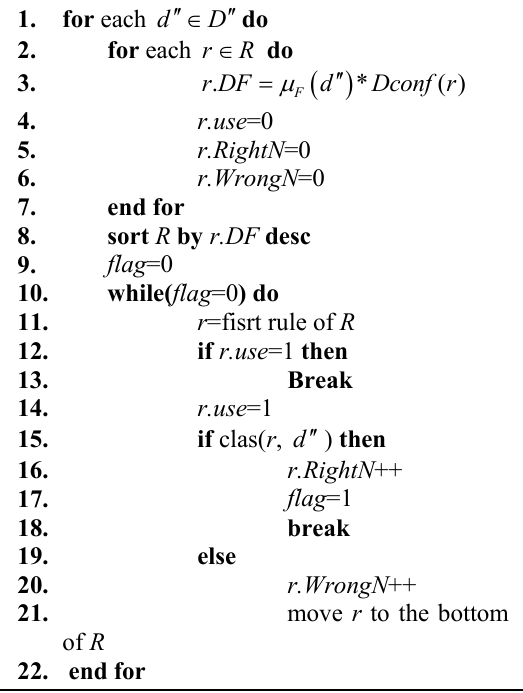
Fig. 3: Procedure 1: